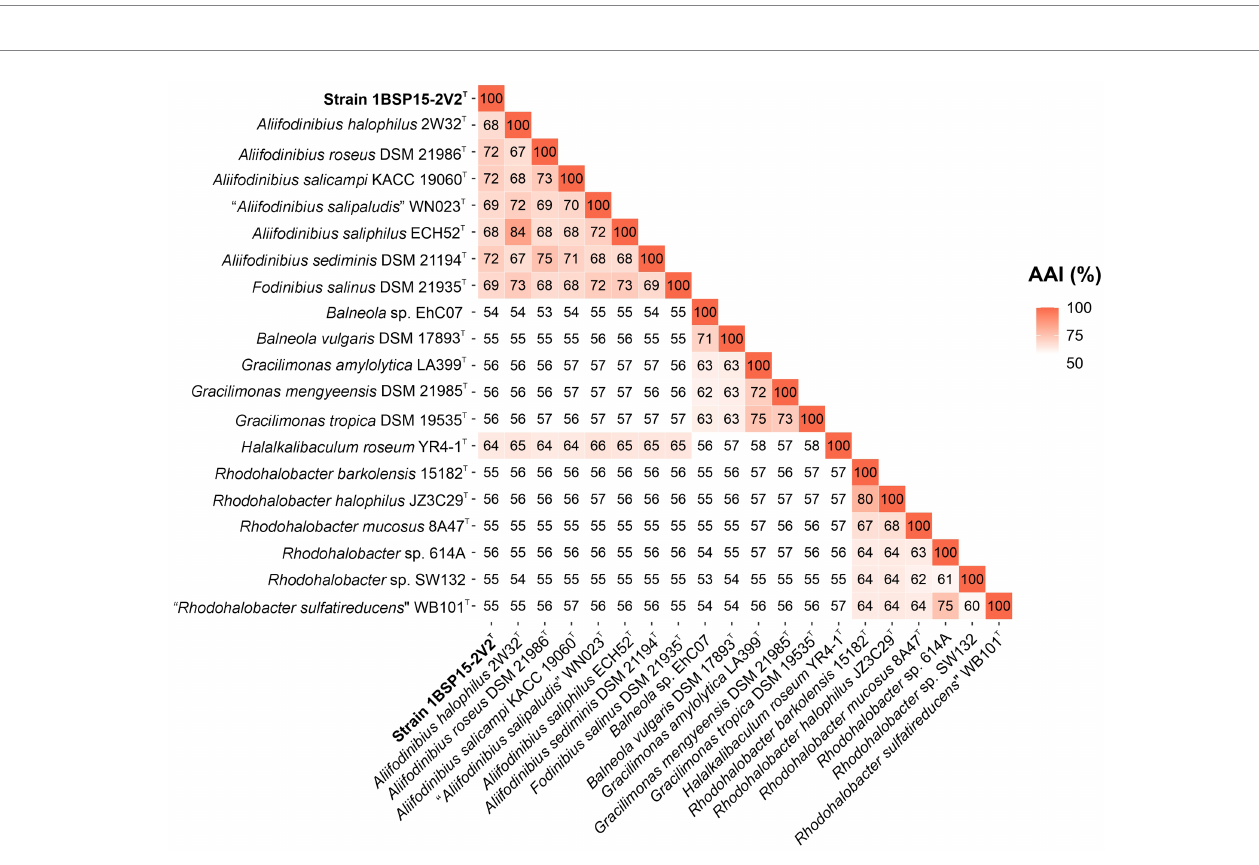
FIGURE 4 AAI matrix among the 20 studied genomes of the family Balneolaceae . AAI values among species of the cluster Fodinibius - Aliifodinibius were all higher than the threshold (65%) accepted for genus delineation. Isolate 1BSP15-2V2 T shared values above 68% with species of the genera Aliifodinibius and Fodinibius , and equal or lower than 64% with other members of the family Balneolaceae , hinting at the affiliation of the novel strain to the genera Alii fodinibius / Fodinibius